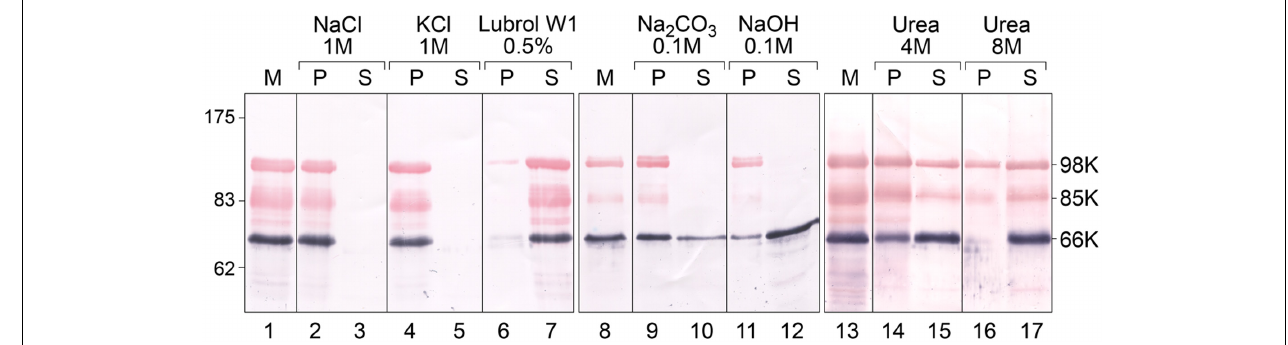
FIGURE 2 | Analysis of the association of TYMV replication proteins with membranes by ionic, alkaline and urea extraction. Membrane fractions (M) were obtained from TYMV-infected Chinese cabbage tissues and were incubated in medium containing 1 M NaCl (lanes 2–3); 1 M KCl (lanes 4–5); 0.5% Lubrol W1 (lanes 6–7); 0.1 M Na 2 CO 3 , pH 11 (lanes 9–10), 0.1 M NaOH (lanes 11–12), 4 M urea (lanes 14–15) or 8 M urea (lines 16–17). Soluble (S) and insoluble pellet (P) fractions were then separated by centrifugation, and each fraction was subjected to 8% SDS-PAGE and immunoblot analysis. Protein samples were revealed sequentially using anti-66K and anti-98K antisera and NBT/BCIP (purple) and Fast Red/Naphtol (red) substrates, respectively. Lanes 1–7, lanes 8–12, and lanes 13–17 correspond to different tissue samples processed and analyzed independently. Molecular mass markers (Biolabs) are indicated on the left, whereas positions of the viral proteins 98K, 85K, and 66K are indicated on the